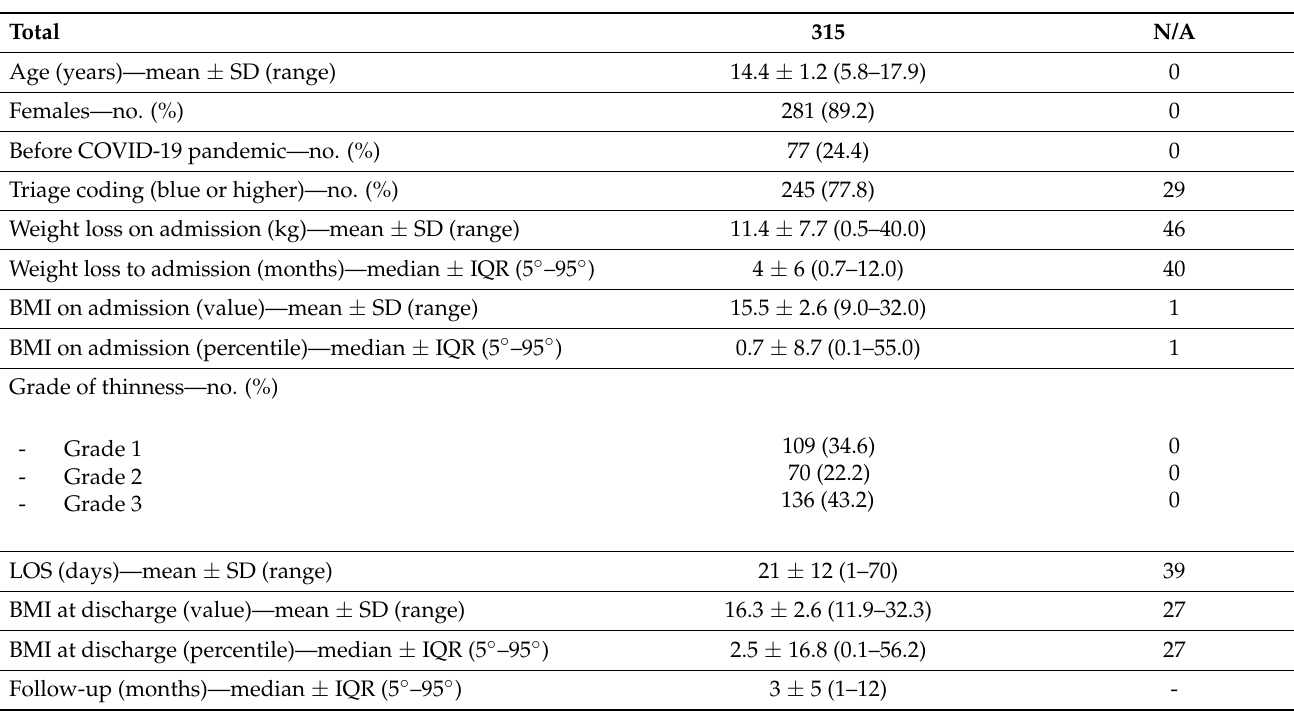
Table 1. Clinical characteristics of study